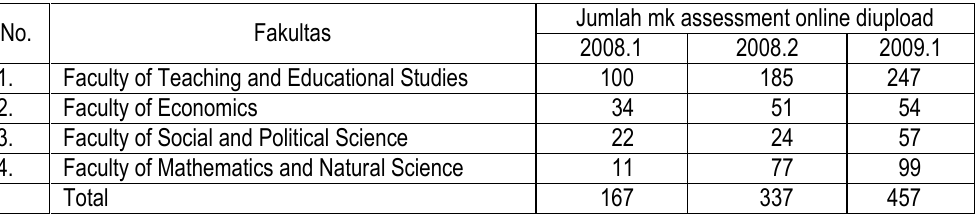
Table 1. The Recapitulation of The Subject on Online Assessment from